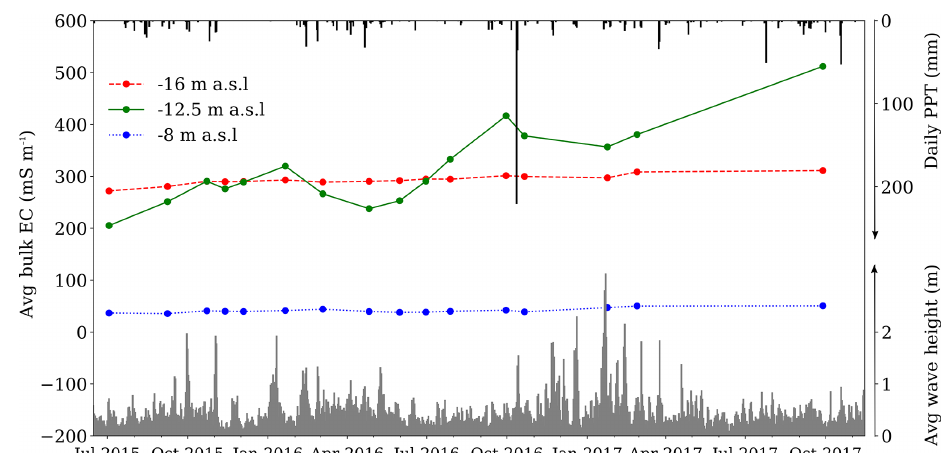
Figure 7. Average conductivities extracted from the inverted models, at − 8ma.s.l. (blue), − 12 . 5ma.s.l. (green) and − 16ma.s.l. (red). Precipitation (PPT) data from Cabrils station and simulated significant wave height time series are displayed. The points indicate times of CHERT campaigns. Note that acquisitions were made before and after the 220mm precipitation event of 12 October 2016. Significant seasonal fluctuations and an overall increase in EC can be seen in the upper part of the semiconfined aquifer (elevation of − 12ma.s.l.) but are negligible in the lower portion of both the shallow unconfined aquifer ( − 8ma.s.l.) and the semiconfined aquifer ( − 16ma.s.l.).